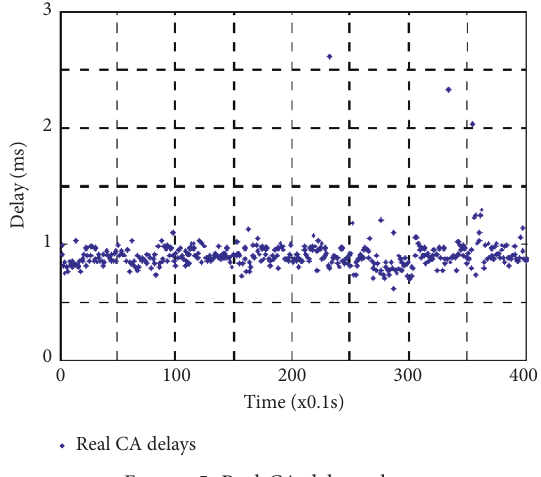
Figure 5: Real CA delay